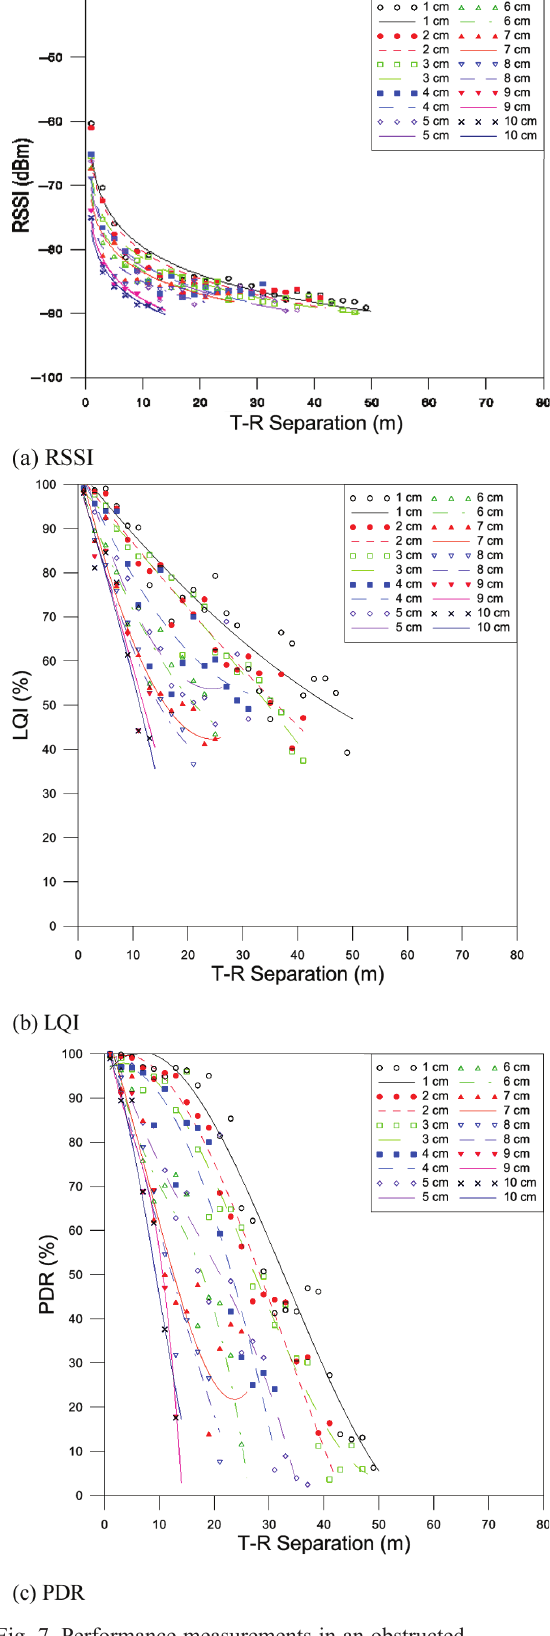
Fig. 7. Performance measurements in an obstructed environment (Steel plate) Fig. 8. Path loss measured from obstructed